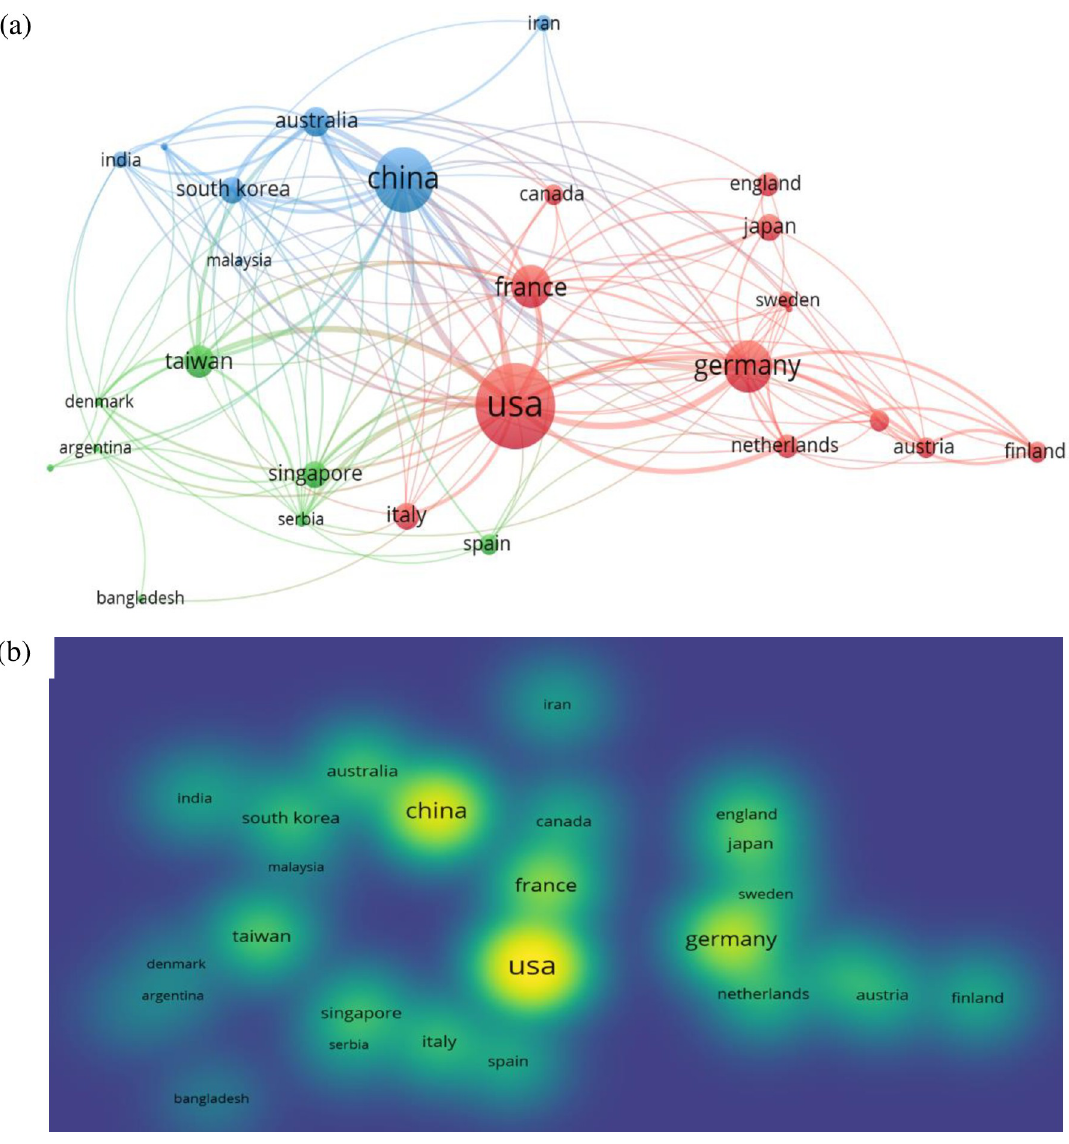
Fig 6. Main affiliations in cognitive research (a) network visualization and (b) density visualization.